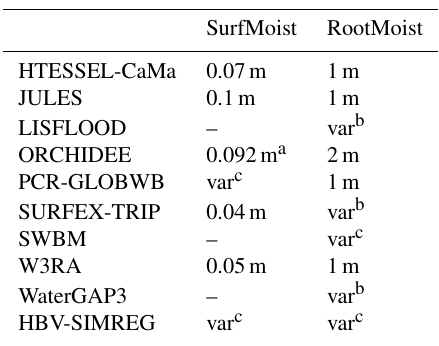
Table 6. Averaging depth of surface moisture and root zone mois- ture in the